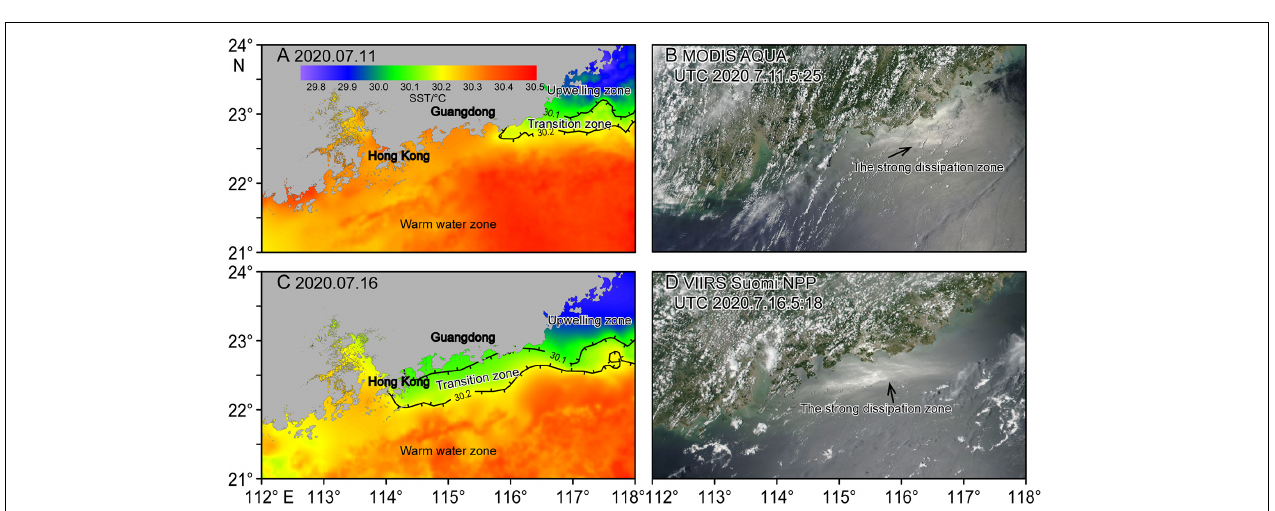
FIGURE 11 | The satellite-composite sea surface temperature (SST) in the study area on July 11, 2020 (A) and July 16, 2020 (C) . Satellite images of the surface roughness acquired by MODIS Aqua and VIIRS Suomi NPP at 05:25 UTC on July 11, 2020 (B) and 05:18 UTC on July 16, 2020 (D) . Comparisons of SST images and satellite images on the same day show that the strong ISW dissipation zones (white wave crests) coincided with the transition zone of the upwelling region (30.1 ◦ C < SST < 30.2 ◦ C).